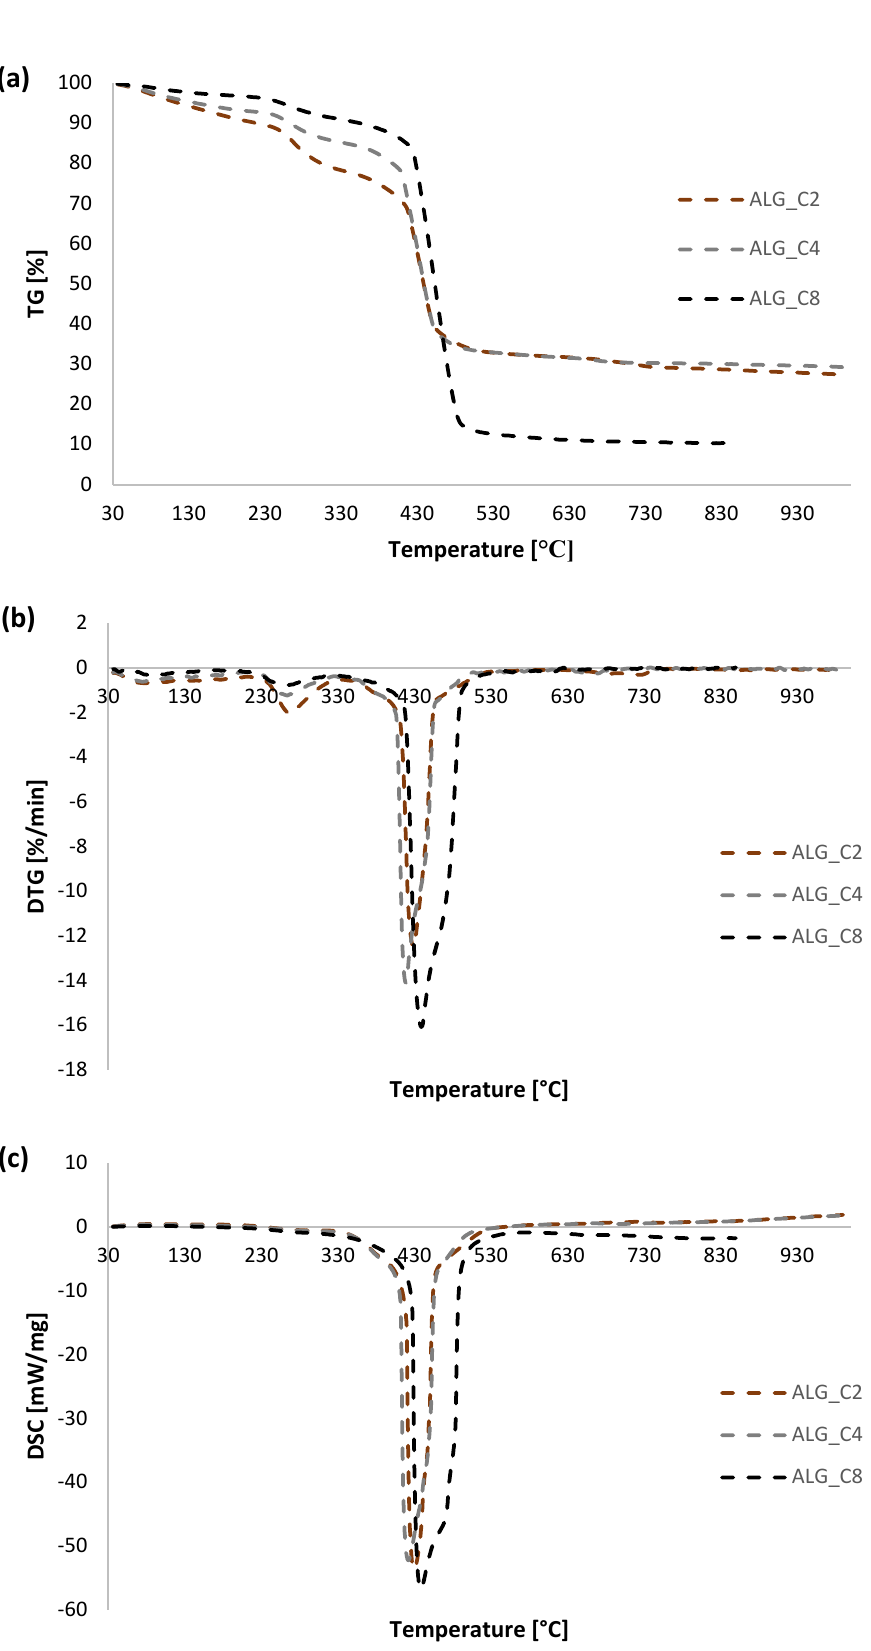
Figure 9. Comparison of TG ( a ), DTG ( b ) and DSC ( c ) curves for ALG_C2, ALG_C4, and ALG_C8 materials.